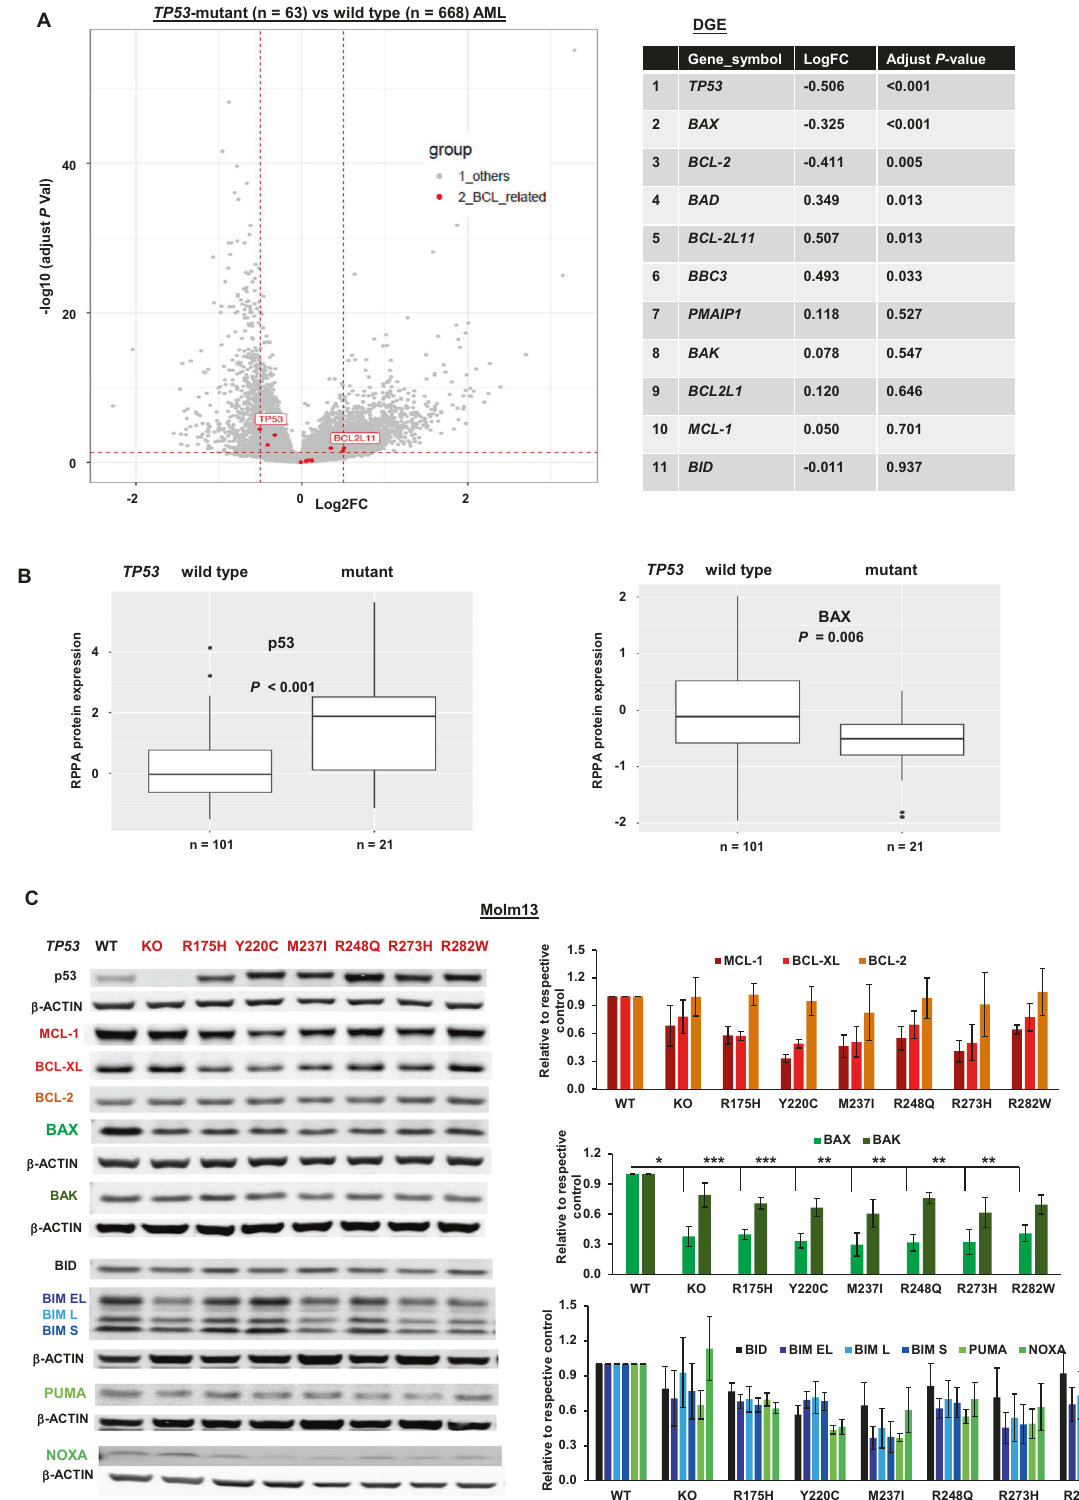
each agent alone in control or TP53- mutant cells. Neither agent alone, nor the combination, activated p53 in TP53 -WT controls, in agreement with the lack of increase of BAX or NOXA. BCL-2 family proteins cooperatively regulate apoptosis through protein-protein interaction (Fig. 3B). Using BH3 mimetic insensitive OCI-AML3 cells, we previously showed that BCL-2